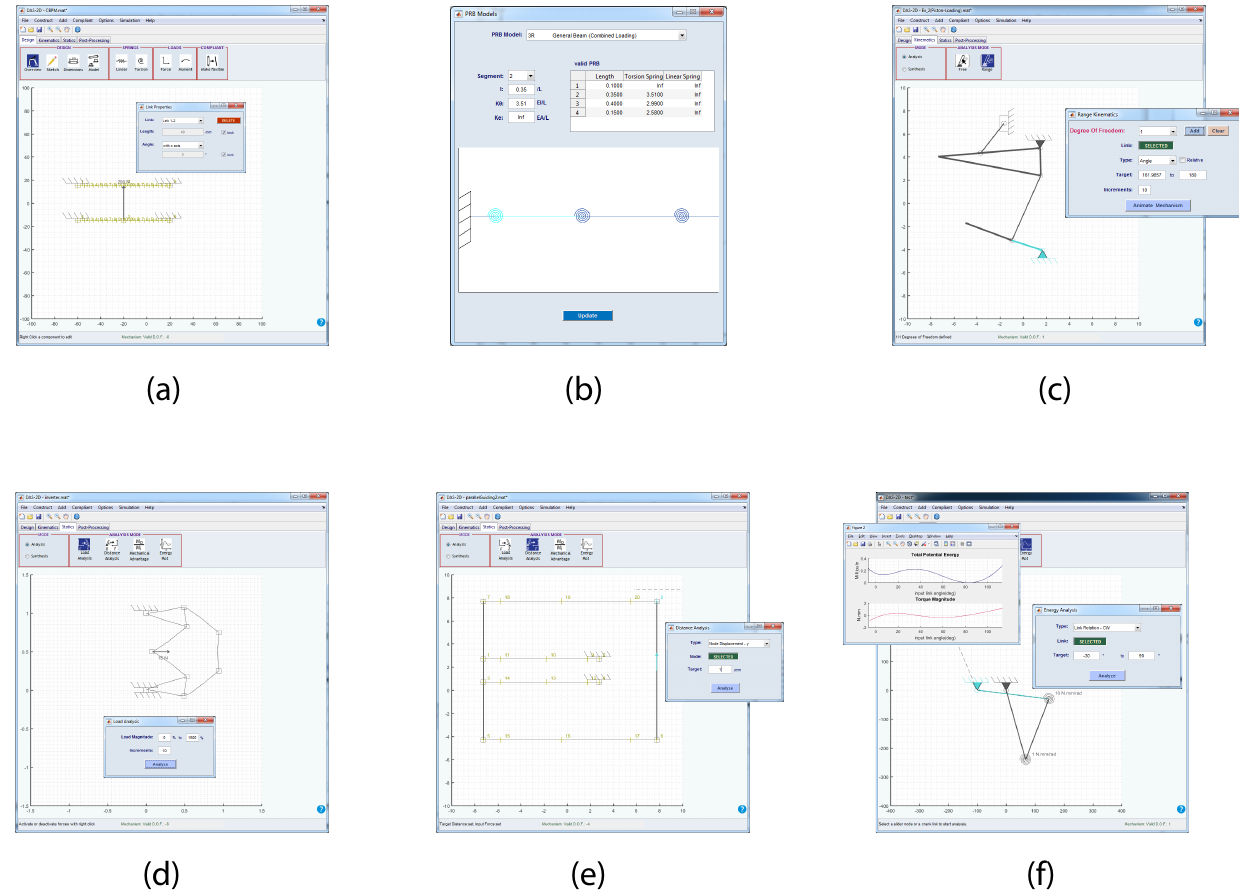
Figure 8. The graphic user interface for the six modules: (a) design, (b) PRB Models, (c) kinematic analysis, (d) load analysis, (e) distance analysis and (f) energy analysis. The software can be downloaded at DISL Software (2016).